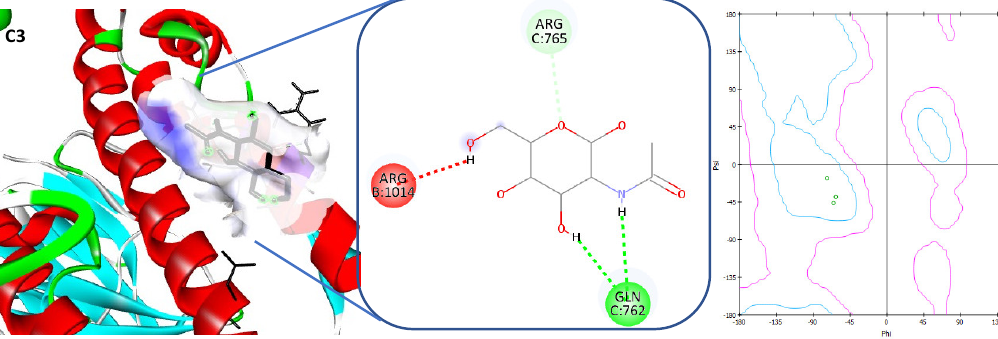
Figure 13. The molecular docking studies of receptor Spike protein S (6VXX) with active constituents of myrrh resin extract with ligands (1) 2,3 − Furandione ( A ); (2) Curzerene ( C ); (3) delta − Elemene ( E ); and (4) Furanoeudesma − 1,3 − Diene ( G ), respectively. The Ramachandran plots of corresponding interactions have been presented to every protein–ligand interaction ( B , D , F , H ). The positive control is shown in ( C3 ).